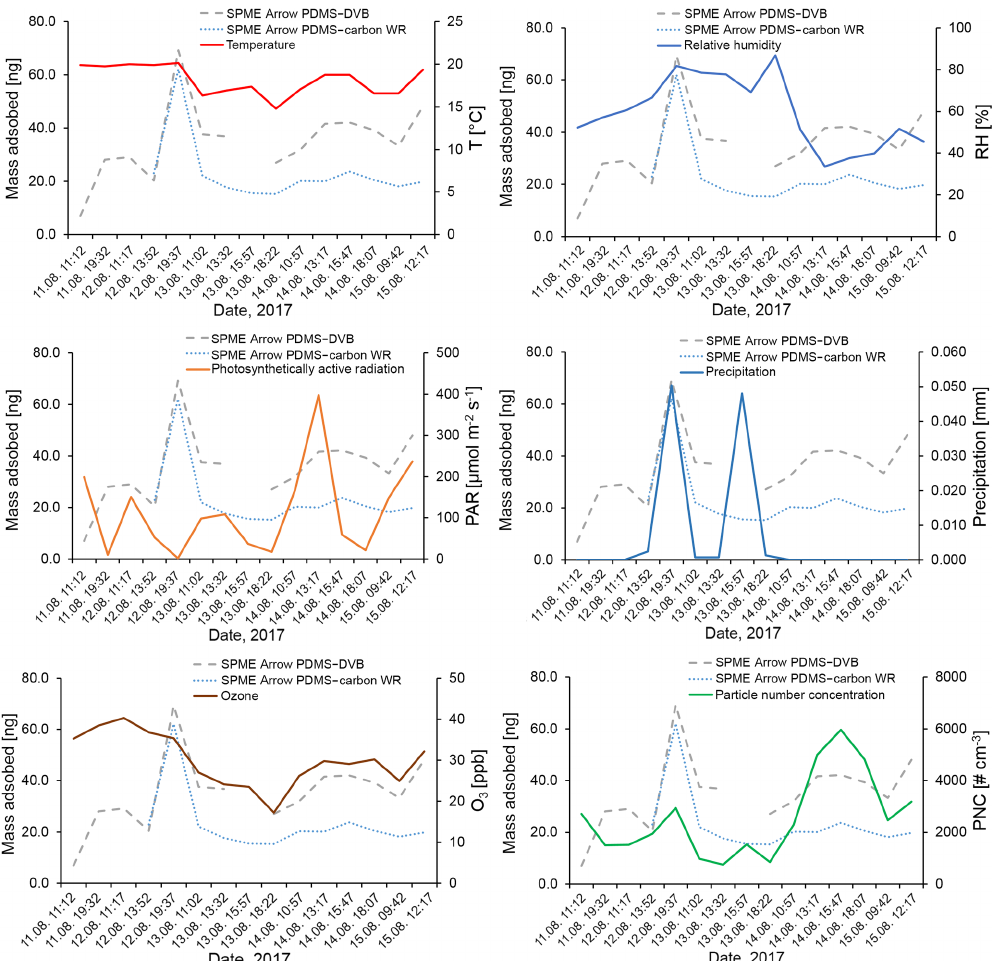
Figure 10. Effect of temperature ( ◦ C), relative humidity (%), photosynthetically active radiation (µmolm − 2 s − 1 ), precipitation (mm), ozone (ppb), and particle number concentration (#cm − 3 ) on the mass of aldehydes adsorbed on the SPME Arrows used in this study (PDMS–DVB and PDMS–carbon WR) and measured by